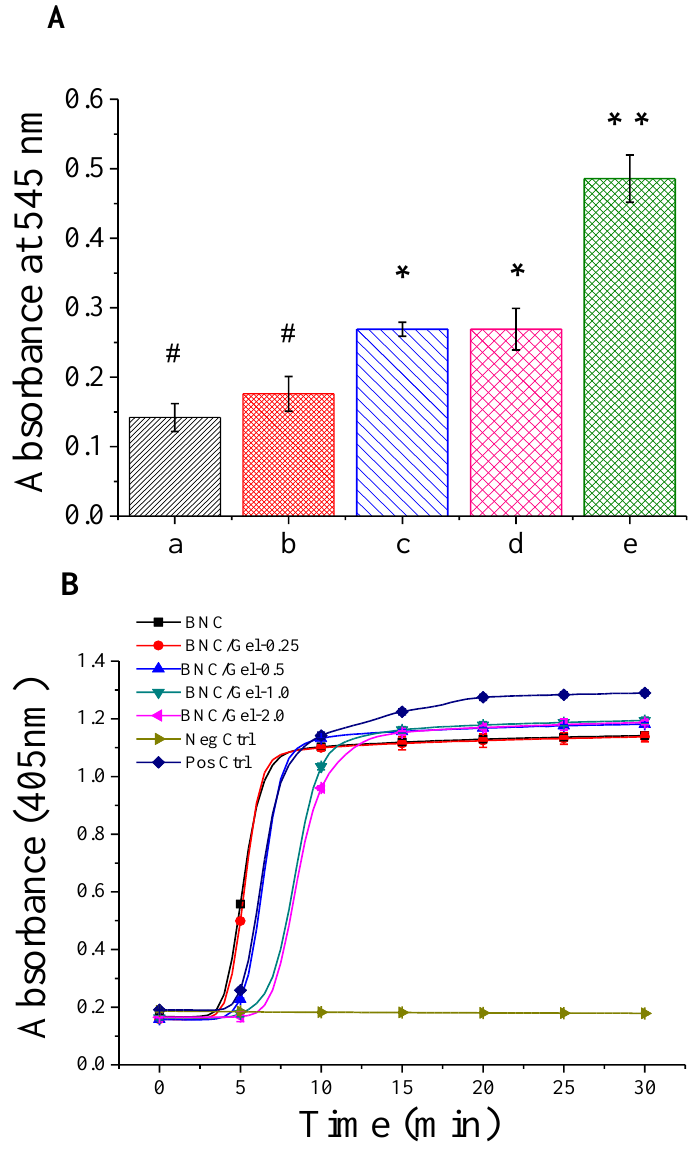
Figure 4. ( A ) Hemolytic rate analysis of BNC tube (a), BNC/Gel-0.25 (b), BNC/Gel-0.5 tube (c), BNC/Gel-1.0 tube (d) and BNC/Gel-2.0 tube (e). ( B ) Plasma recalcification dynamics process of BNC and BNC/Gel tubes along with controls. (** p < 0.01, * 0.01 < p < 0.05, # p > 0.05).